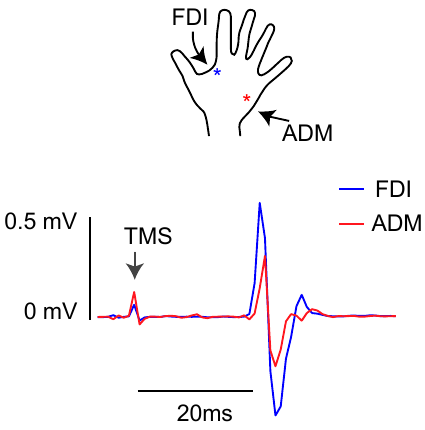
Figure 1. Typical EMG recording for FDI (blue trace) and ADM (red trace) muscle activity during rest. During the stimulation (TMS), artifacts on EMG trace are also shown.